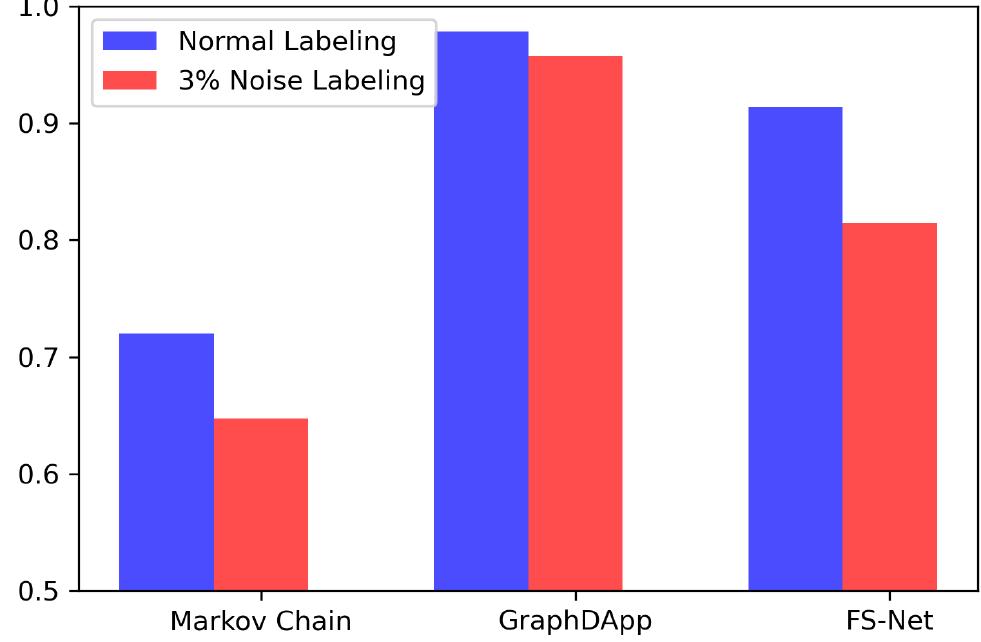
Figure 9. Comparison of classification accuracy with normal labeling and 3% noise